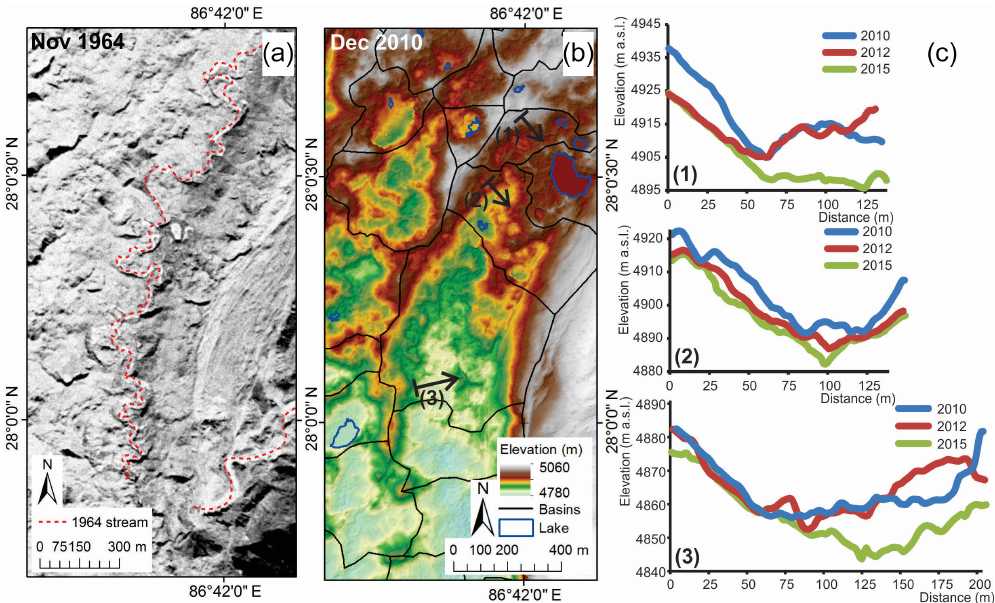
Figure 15. Evolution of the eastern margin of the main trunk of Ngozumpa Glacier, 1964–2015. (a) Supraglacial streams on the glacier surface in 1964 Corona imagery; (b) 2010 DEM, showing surface basins and the location of profiles; (c) surface profiles in 2010, 2012, and 2015, showing patterns of